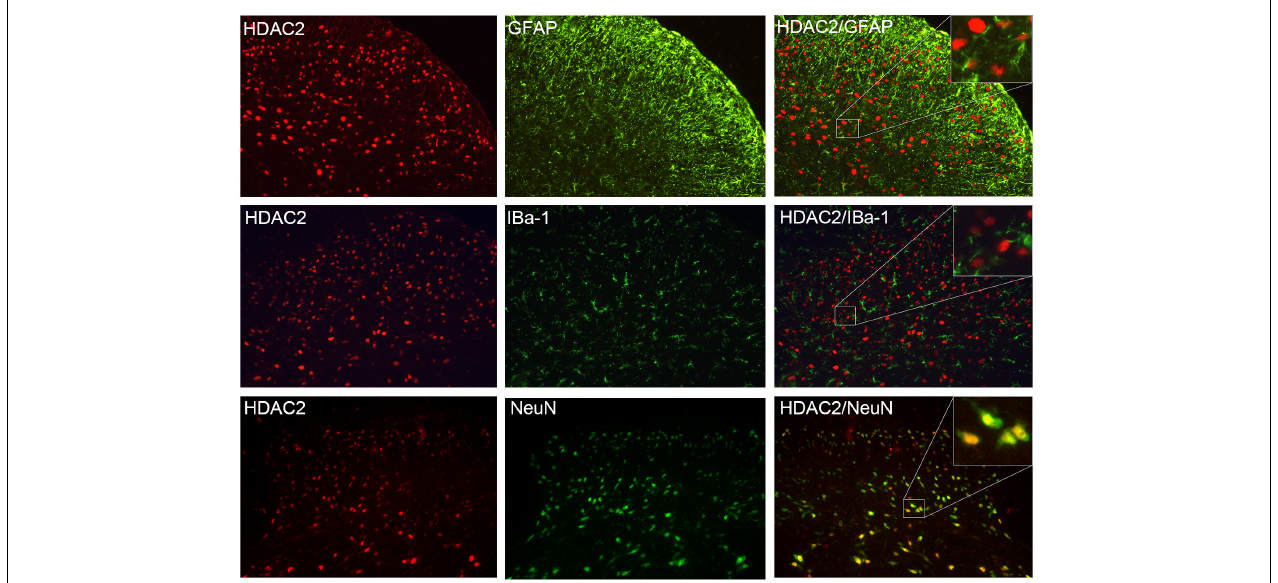
FIGURE 3 | HDAC2 was primarily expressed in neurons. HDAC2 signal (red) was highly co-localized with NeuN (marker of the neuron, green). There was no overlap between HDAC2 and the astroglial marker GFAP (green), or HDAC2 with the microglial marker IBa-1 (green).